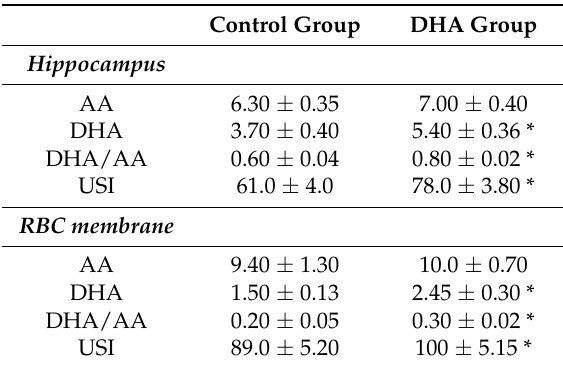
Table 1. Effect of oral administration of DHA on the fatty acid profile (mol %) of the hippocampus and red blood cell (RBC) membrane.